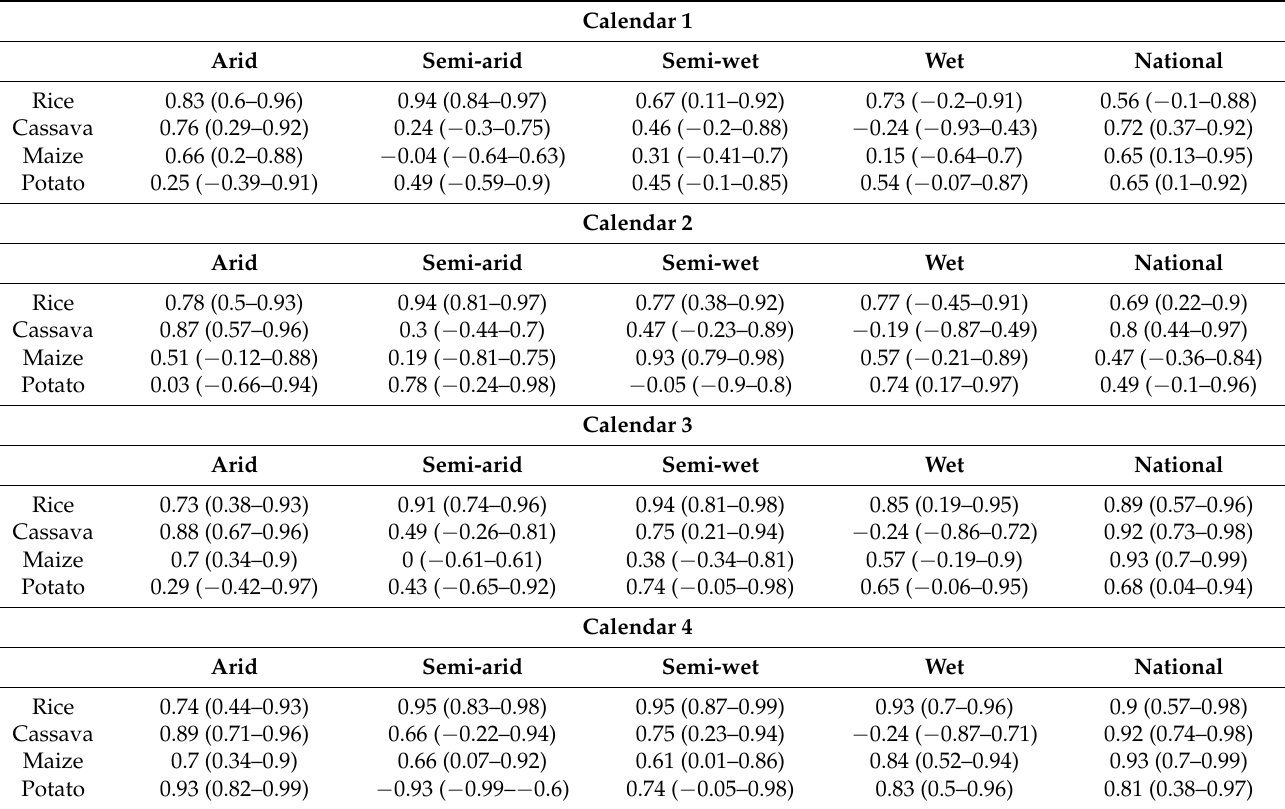
Table 2. The correlation ( r ) between SM Values in parentheses represent 90% confidence intervals. We evaluate Equation (1) using soil anomalies that are based on planting and harvesting dates (SM with a fixed length of eight months (SM shown in (Table